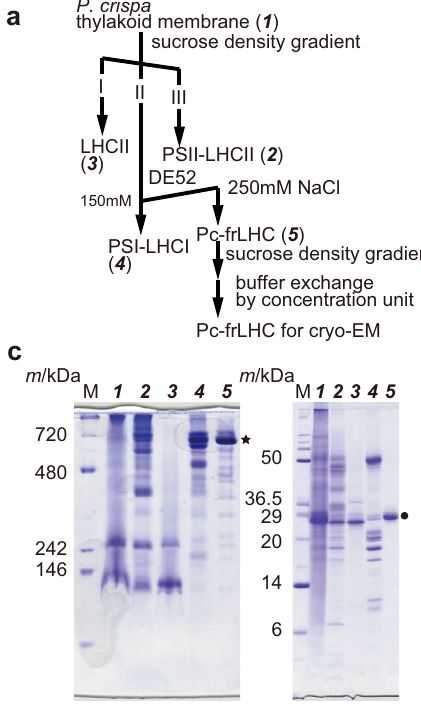
experiments. d Fitting analysisof the absorbance spectrum ofpuri fi ed Pc-frLHC at roomtemperature. Thepeakwavelength of eachcomponentwasestimated bythe secondandfourthderivativesoftheabsorbancespectrum,and fi ttinganalysiswith Gaussian functions was performed by Magic plot 2.7.2 (Magicplot Systems, St. Petersburg, Russia). The components of LWC 708 and LWC 725 are shown by the orange and blue lines, respectively. The observed absorbance spectrum and the sum of each component of the Gaussian function are shown by black and dotted red lines, respectively. a.u.: arbitrary unit. Source data are provided as a Source Data fi